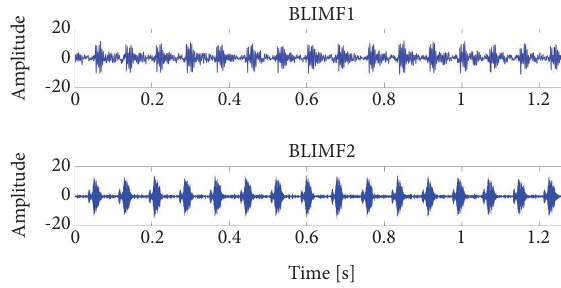
Figure 7: Two groups of BLIMF components of early VMD.